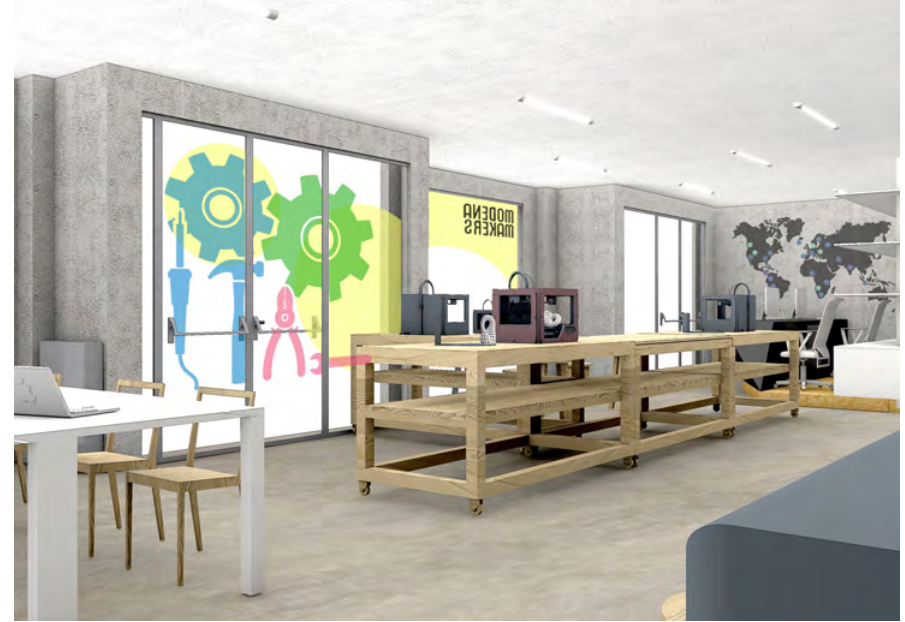
Figure 2. An example of FAB